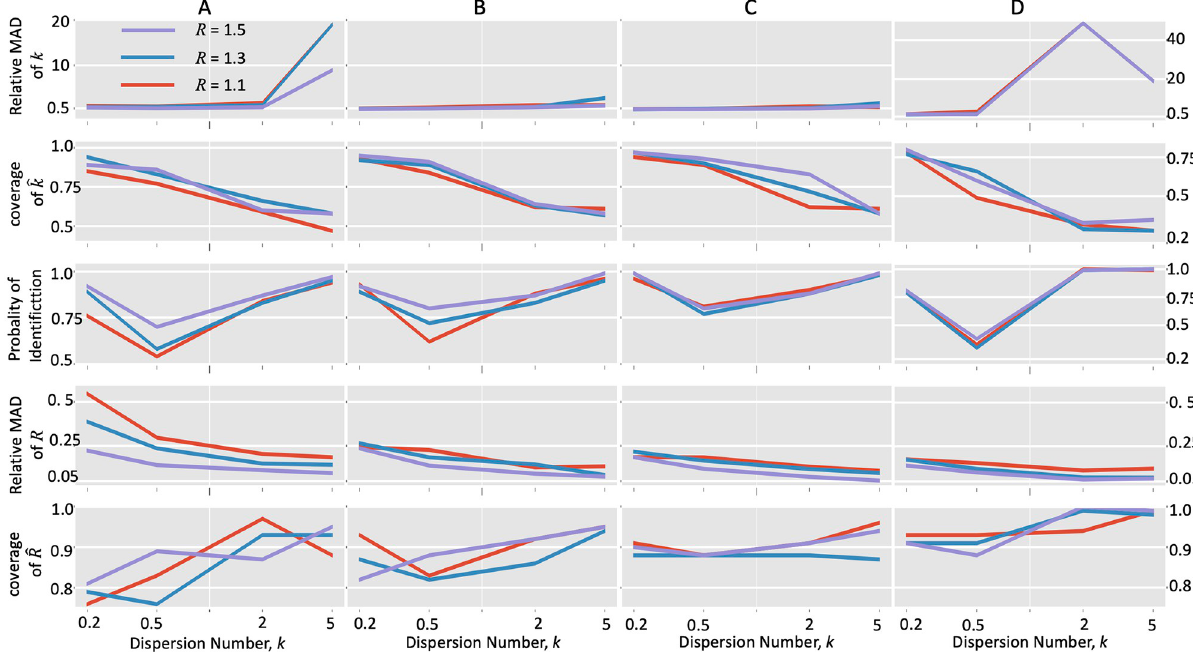
Fig 1. Accuracy of the instant-individual heterogeneity model in estimating transmission dynamics with simulated data. Incidence data were generated with the instant-individual heterogeneity model (4) with given reproduction number and dispersion number. Each simulation began with 10 cases and stopped at 24 days. The relative MADs and the coverage of 95% high probability density interval were calculated for the estimation of reproduction number R and dispersion number k respectively. The probability of identification (defined in the section of methods) was also calculated for the estimation of dispersion number k . A, B, and C. Estimation with daily reported incidence data of different time lengths, i.e., window size = 7 days (A), 14 days (B), and 21 days (C); D. Estimation with irregularly reported incidence data, where the incidence data were generated every day or every three days